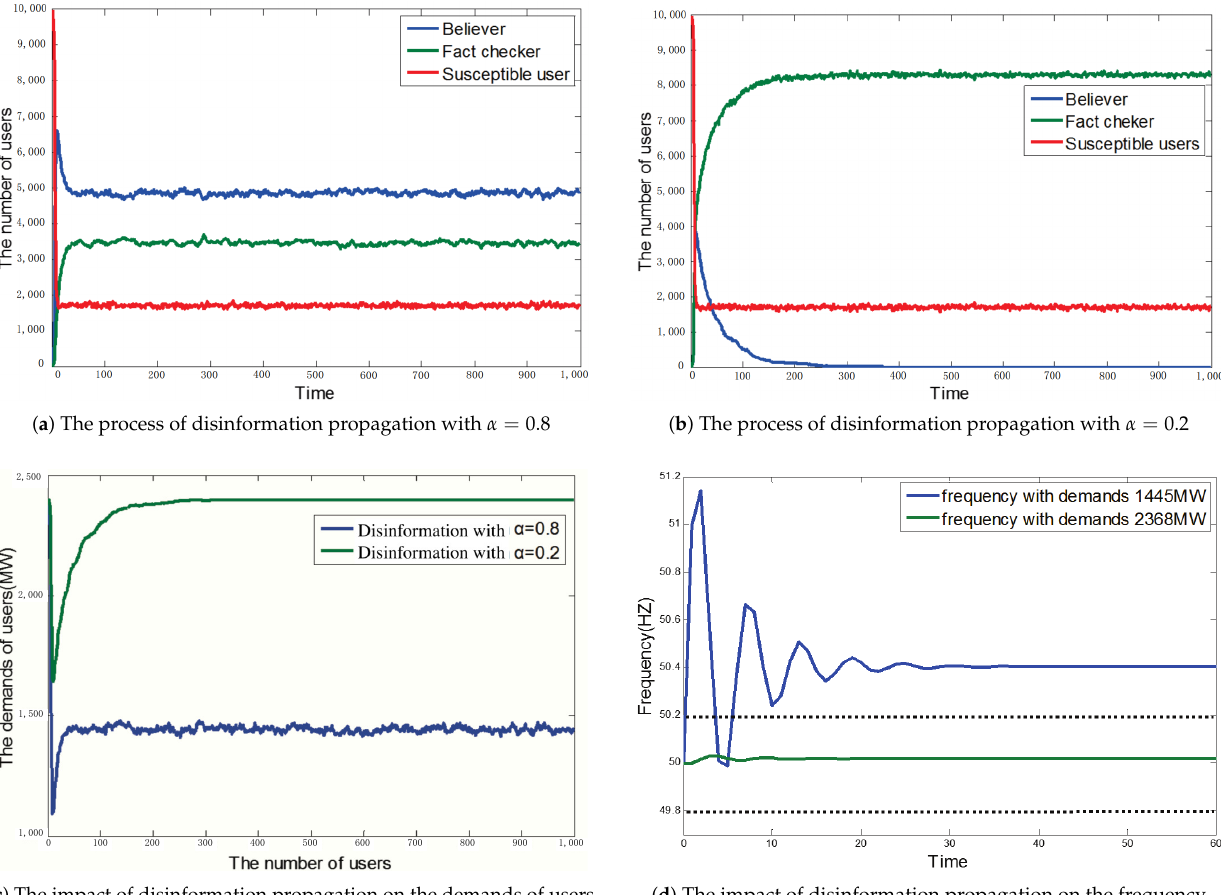
Figure 13. Comparing the effects of the disinformation attack with α = 0.8 and with α = 0.2, where β = 0.5 and initial demand is 2400